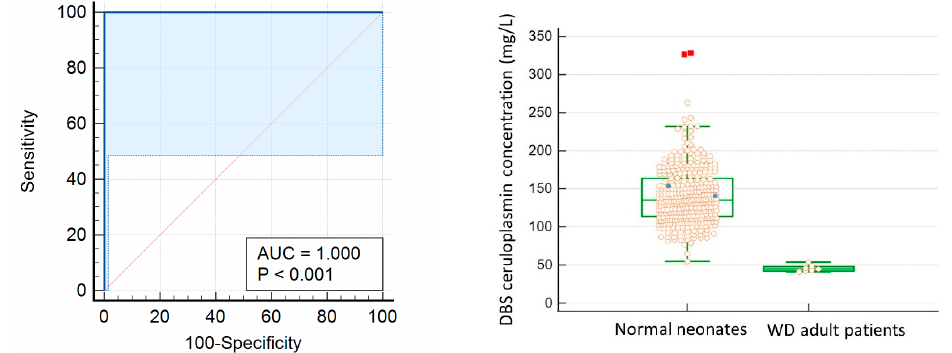
Figure 1. ( Left ) The ROC curve for diagnosis of WD using DBS ceruloplasmin level. To differentiate normal newborn from WD adult samples, the optimal cut-off value is 54 mg/L with 100% sensitivity and specificity. Area under curve is 1.000. ( Right ) Box-and-Whisker plot: solid circle: WD adult heterozygotes; red square: outliers.